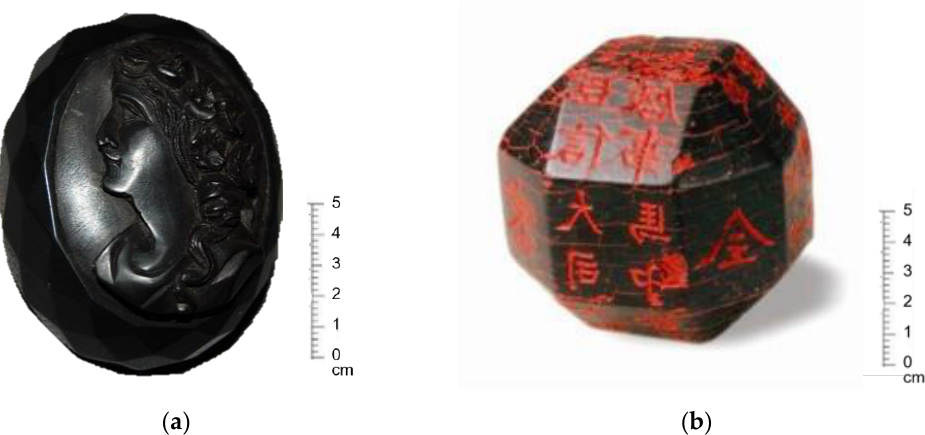
Figure 1. Typical jet products. ( a ) Queen Victoria Head of England; ( b ) Chinese Dugu letter 26 face body seal.